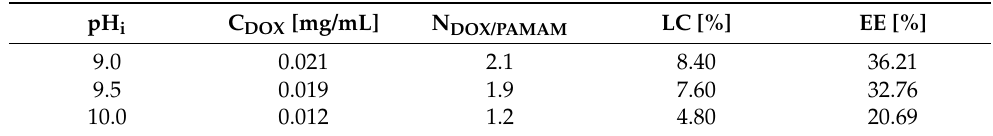
Table 1. Doxorubicin concentrations in G4.0 PAMAM-DOX 1:6 complexes after dialysis depending on the pH of complex formation in terms of the number of DOX particles per dendrimer molecule (N DOX/PAMAM ), loading content (LC), and encapsulation efficiency (EE).